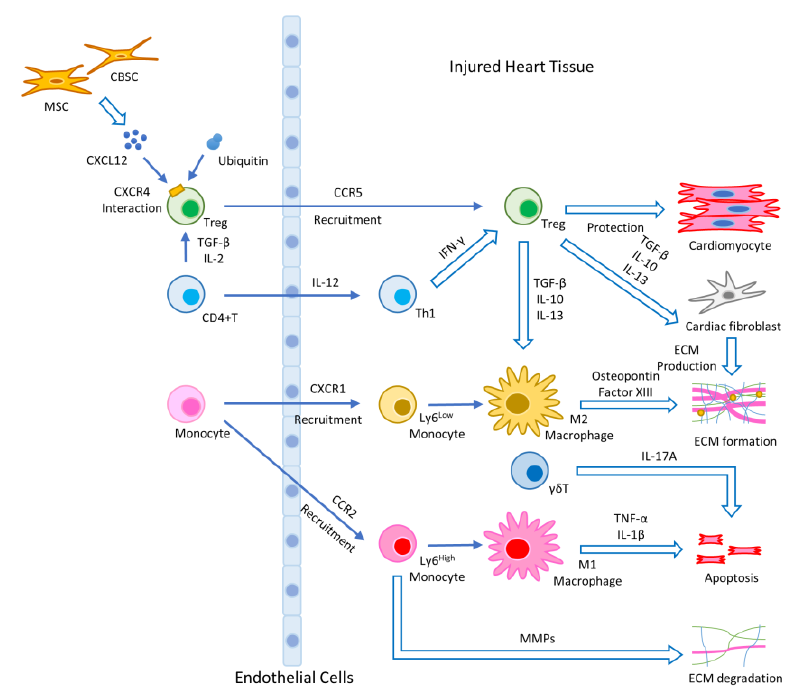
Figure 1. Illustration of the wound healing process after stem cell therapy: activated monocytes/macrophages produce various chemokines and cytokines that initiate inflammation and cell migration. Chemokines produced at the site of infarction induce CCR2-dependent migration of proinflammatory Ly6C high monocytes, which secrete pro-inflammatory cytokines and produce a MMP to degrade ECM. Ly6C high pro-inflammatory monocytes differentiate into classically activated M1 macrophages that express IL-1β and TNF-α. The migration of anti-inflammatory Ly6C low monocytes is mediated via CXCR1. Ly6C low reparative monocytes can differentiate into alternatively activated M2 macrophages. MI induces the activation and proliferation of CD4 + T cells in the heart-draining lymph nodes, which express high levels of IFN- γ at the site of infarction. Additionally, γδ T cells participate in apoptosis. Tregs produce IL-10, IL-13, and TGF- β and play an important role in the resolution of inflammation and cardiac repair following MI. MSCs and CBSCs produce chemokine. CXCL12 is a ligand of CXCR4, and exogenous ubiquitin interacts with CXCR4. They participate in cardioprotective function with